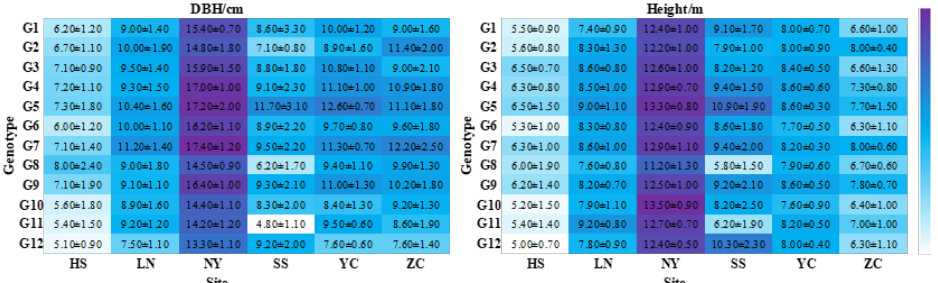
Figure 2. Descriptive statistics of DBH and height. “Mean Value ± Standard Deviation” is the data format in the figure. The position of the bottom horizontal axis represents six locations from left to right: “Heishan”, “Luannan”, “Ningyang”, “Shishou”, “Yuncheng”, and “Zhucheng”.